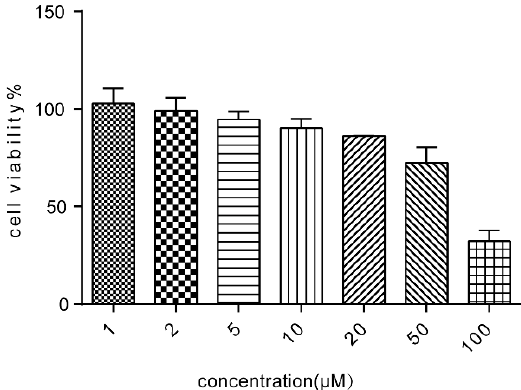
Figure 5. Cell viability of MCF-7/DOX cells following treatment with various concentrations of ALI. Results were means ± SEM of three separate experiments.